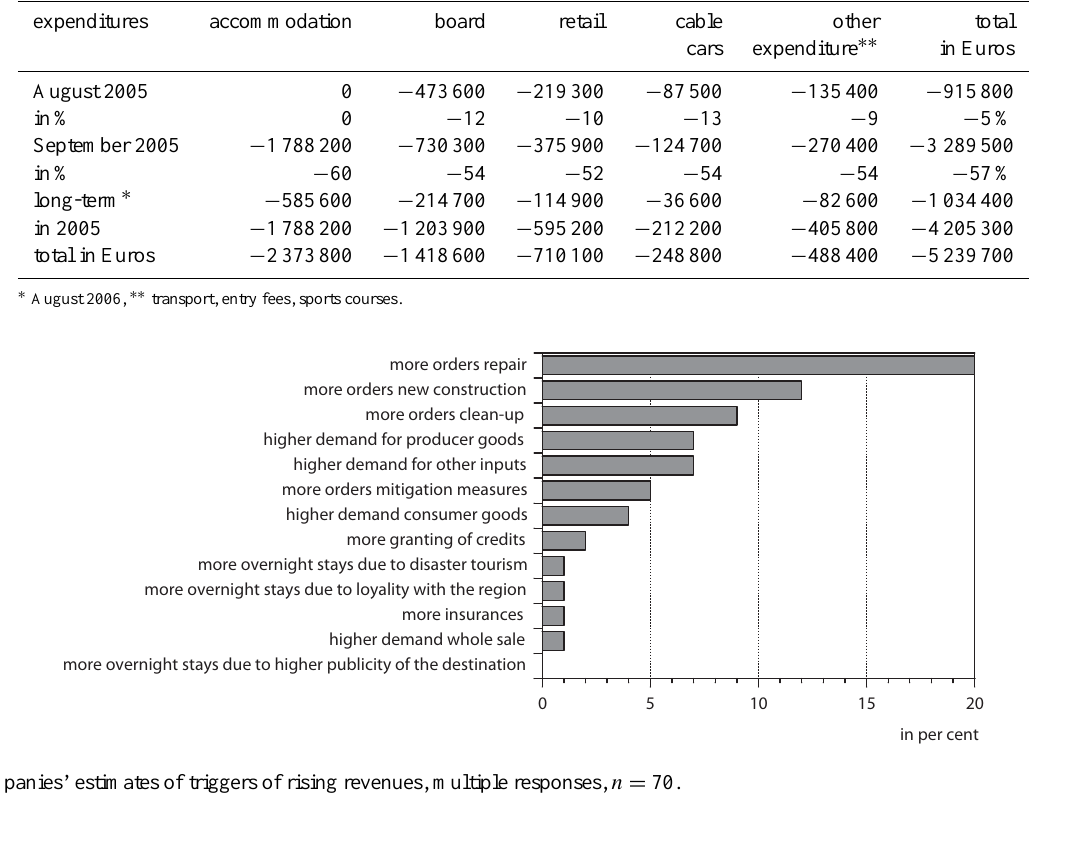
Table 3. Results of the calculation of the decline in touristic income in the Paznaun valley as a result of the 2005 flood event, based on Nöthiger (2003), in 2011 Euro values; input data provided by the Paznaun tourism association (D. Walser, personal communication, 2011).